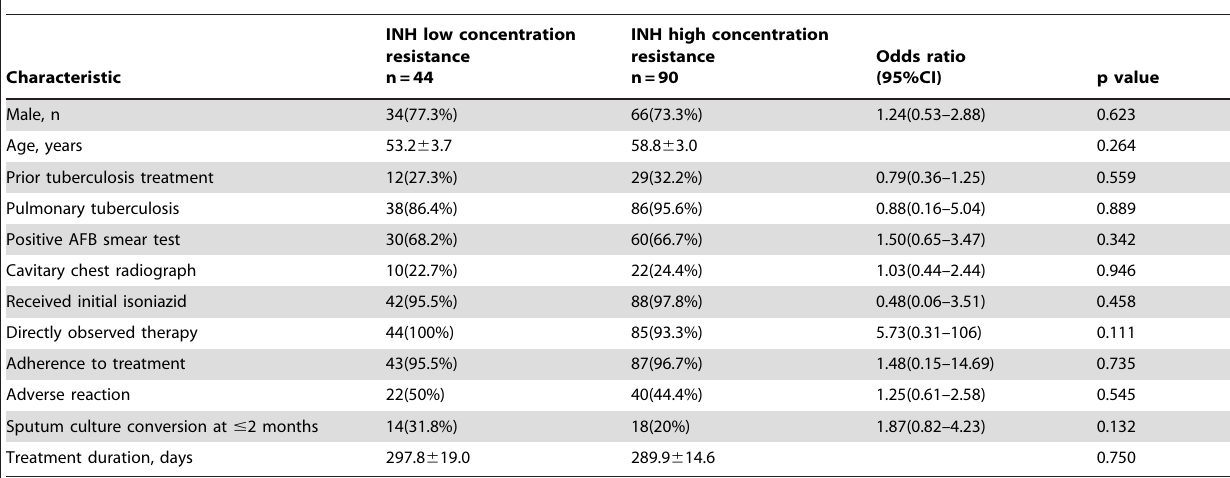
Table 1. Demographic and clinical characteristics of the patients.